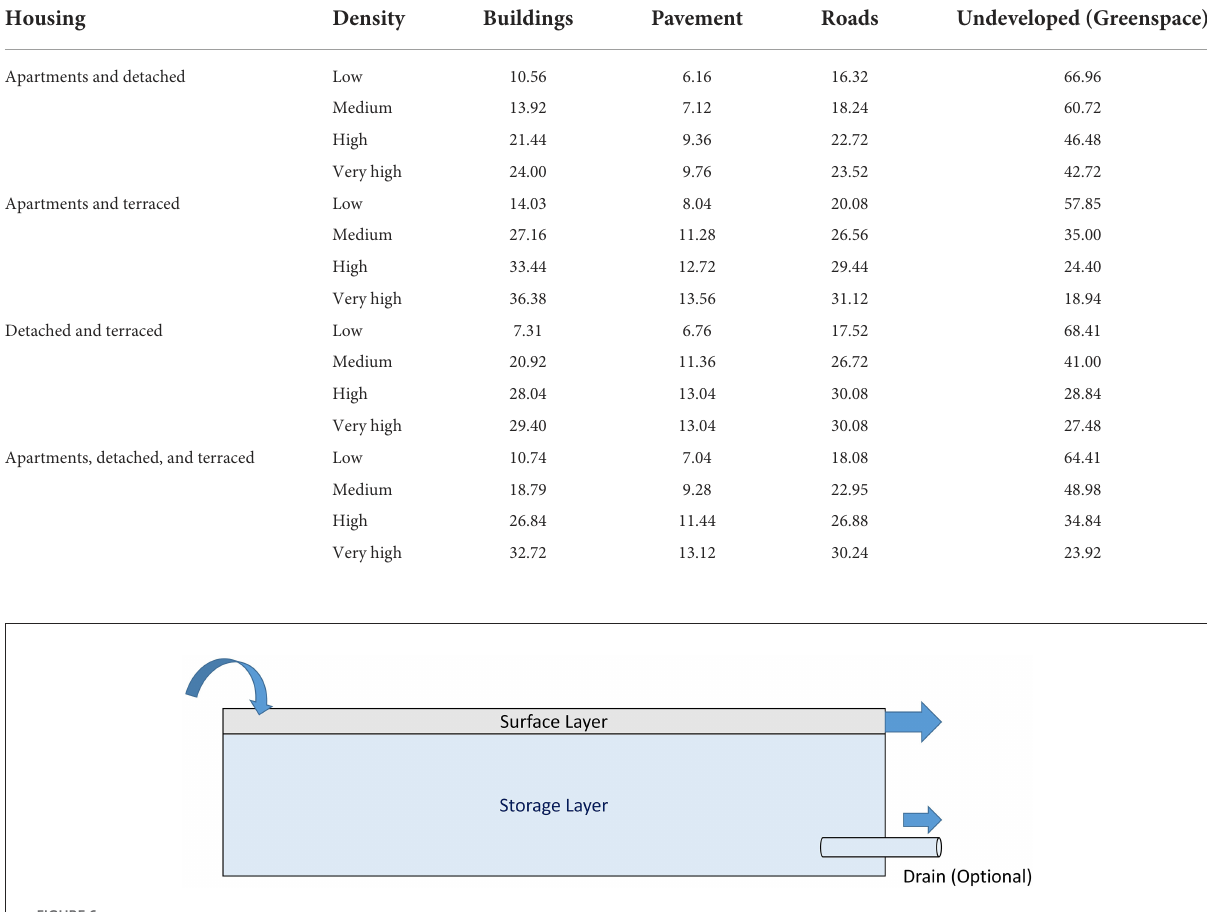
FIGURE6 SWMM conceptualization of a retention basin system [adapted from EPA